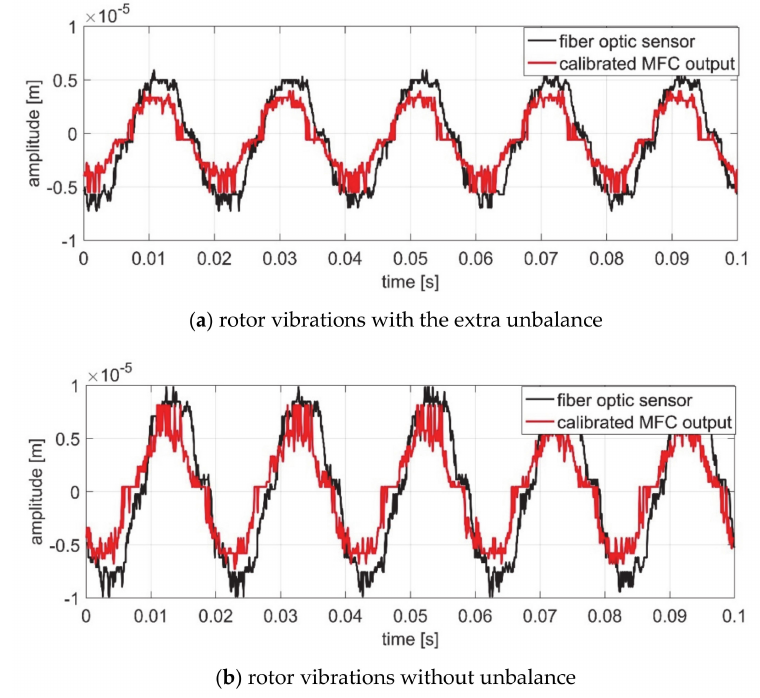
Figure 18. Comparison of the rotor radial